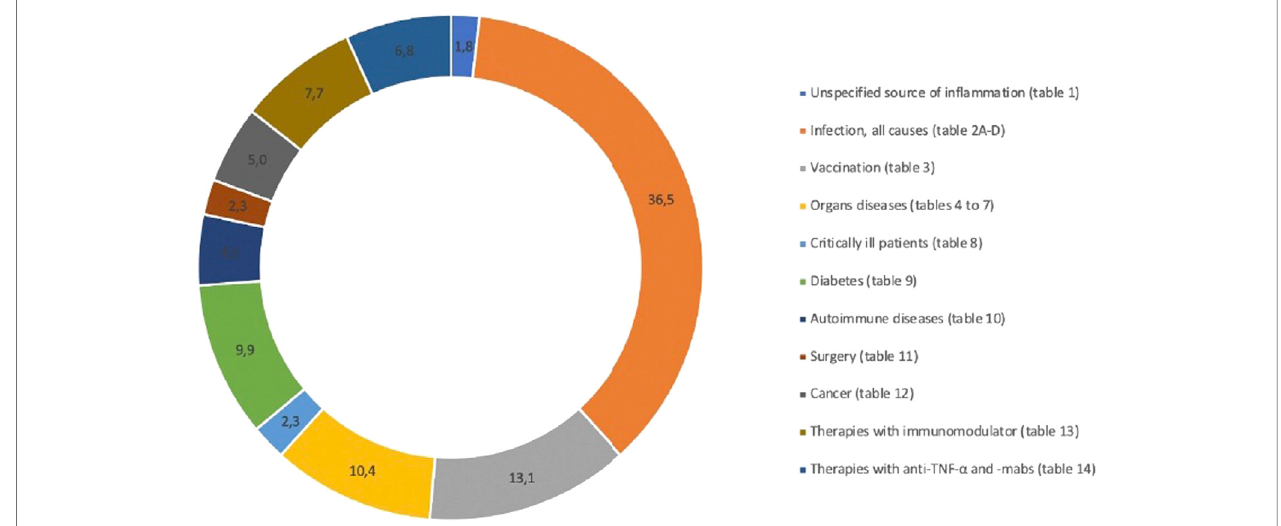
FIGURE 2 | Distribution (%) of included references according to the different sources of in fl ammation.